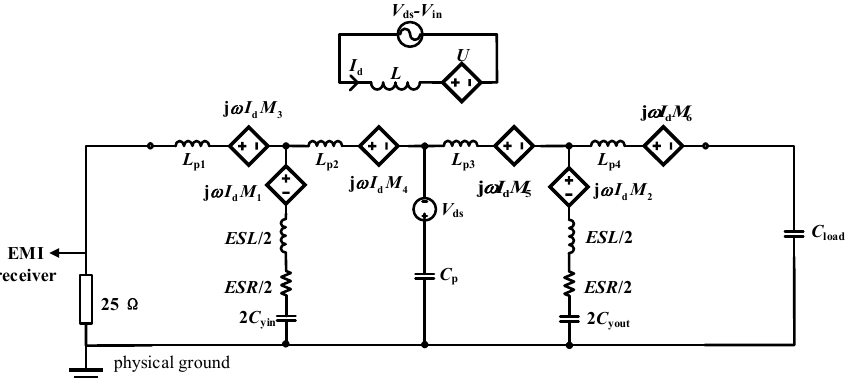
Figure 8. Basic CM conducted emission circuit model including magnetic coupling.